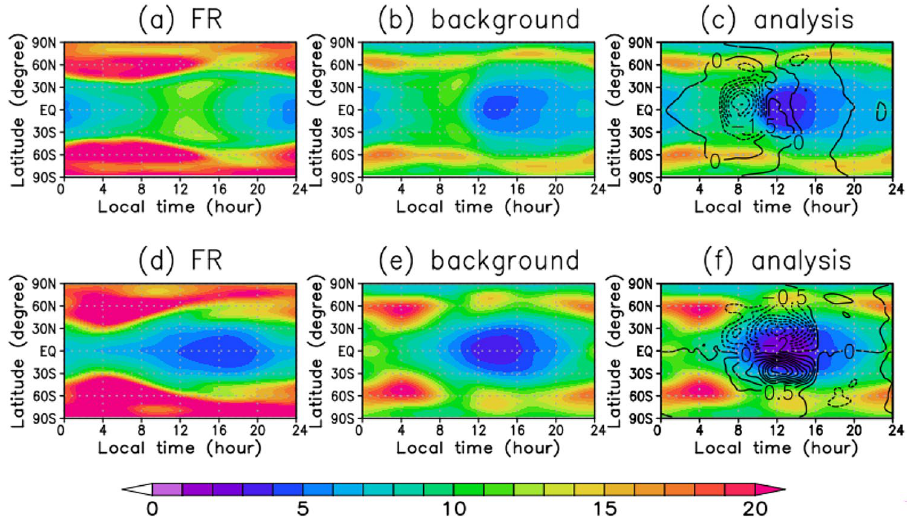
Figure 8. Local time and latitudinal distributions of ensemble spread (colour, m s −1 ) and ensemble increment (contour, m s −1 ) for ( a , b , c ) zonal winds and ( d , e , f ) meridional winds (m s −1 ) associated with thermal tides at the cloud-top (~ 70 km) level. ( a , d ) FR spreads, ( b , e ) background spreads and ( c , f ) analysis spreads and increments. The contour intervals of ensemble increment are 0.5 m s −1 . These distributions are averaged for the two Earth months from 1 October to 30 November 2018 in a reference frame moving with the Sun to extract the structures associated with thermal